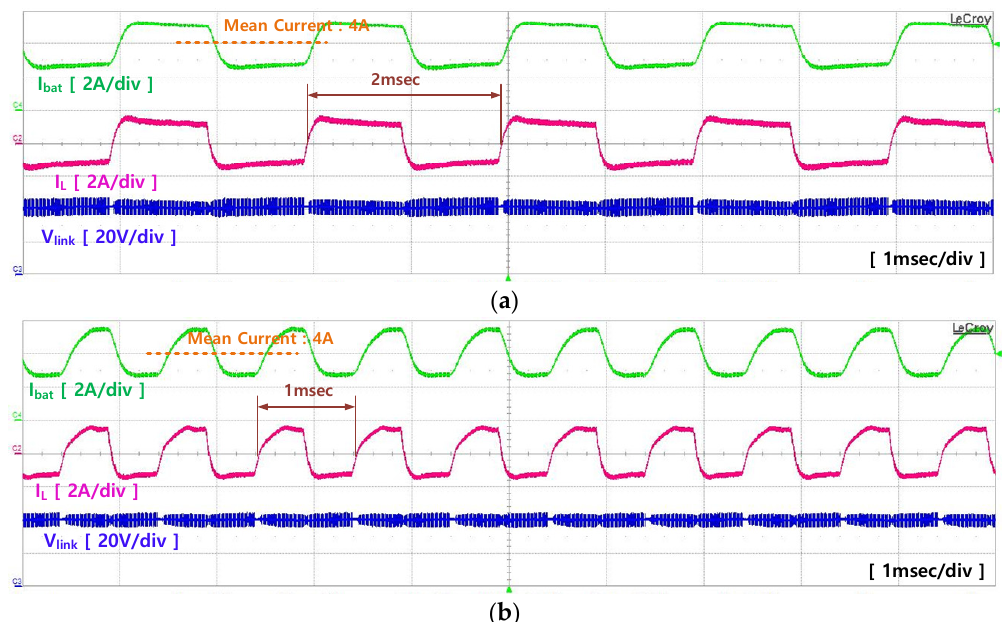
Figure 13. Characteristics of the steady state: ( a ) pulse frequency: 500 Hz and ( b ) pulse frequency: 1000 Hz.